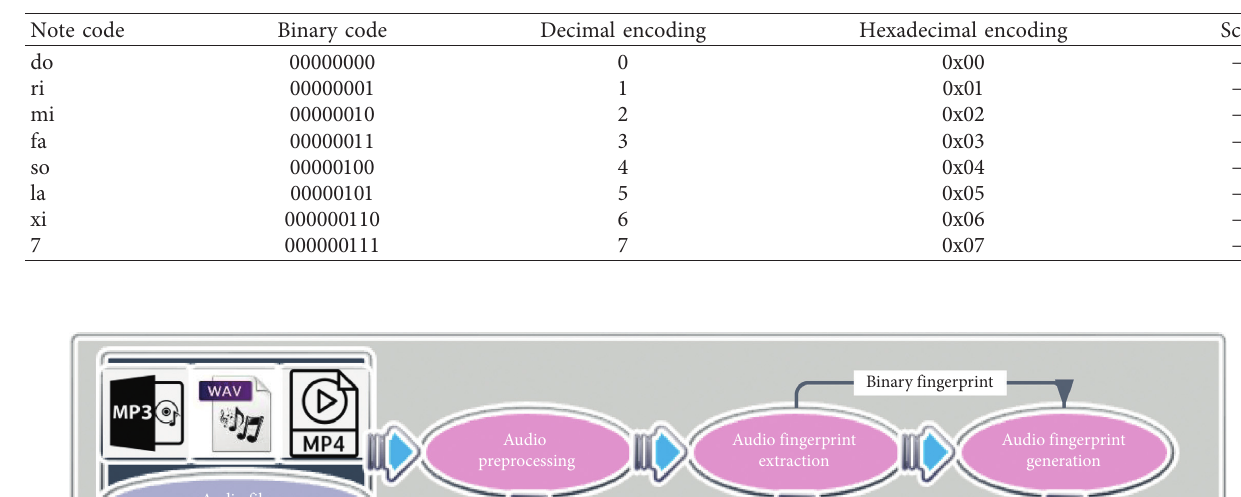
Table 1: MIDI note code table.